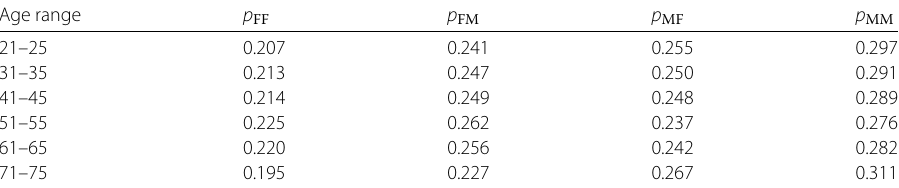
Table 1 The probabilities used in the null model that are used to calculate the normalized scores corresponding to the results in Fig. 2. The values shown below correspond to the age brackets used in Fig. 2. The probabilities for the different pairs are calculated using equations similar to Eq. (2) (for FF